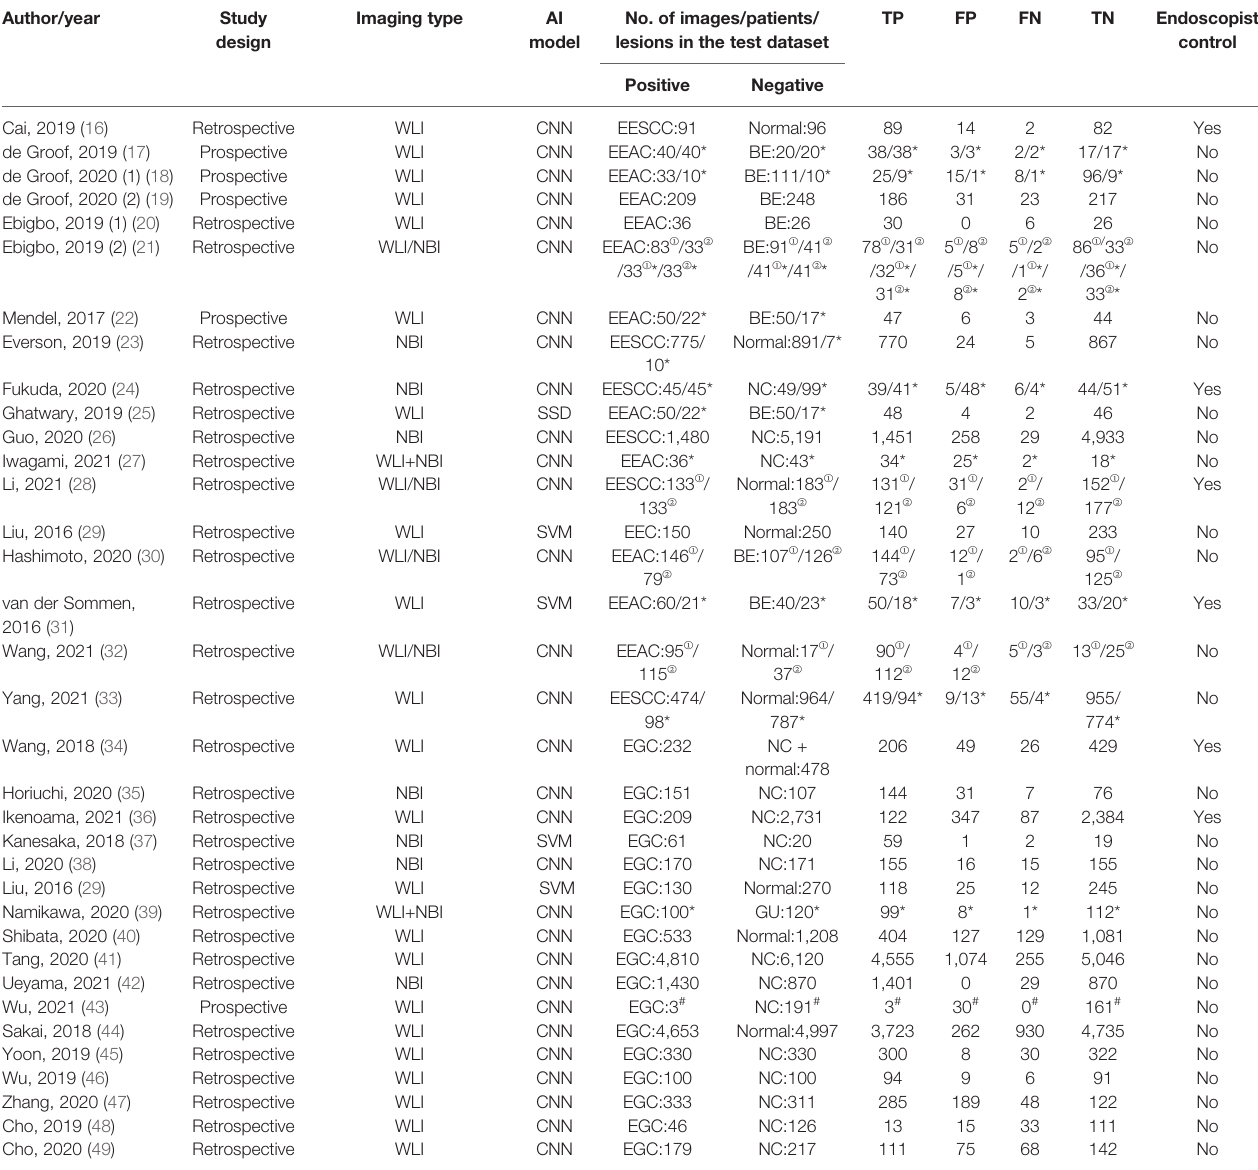
TABLE 1 | Clinical characteristics of the included